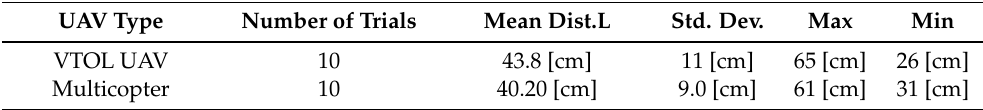
Table 4. Results of VTOL UAV and tethered multicopter landing